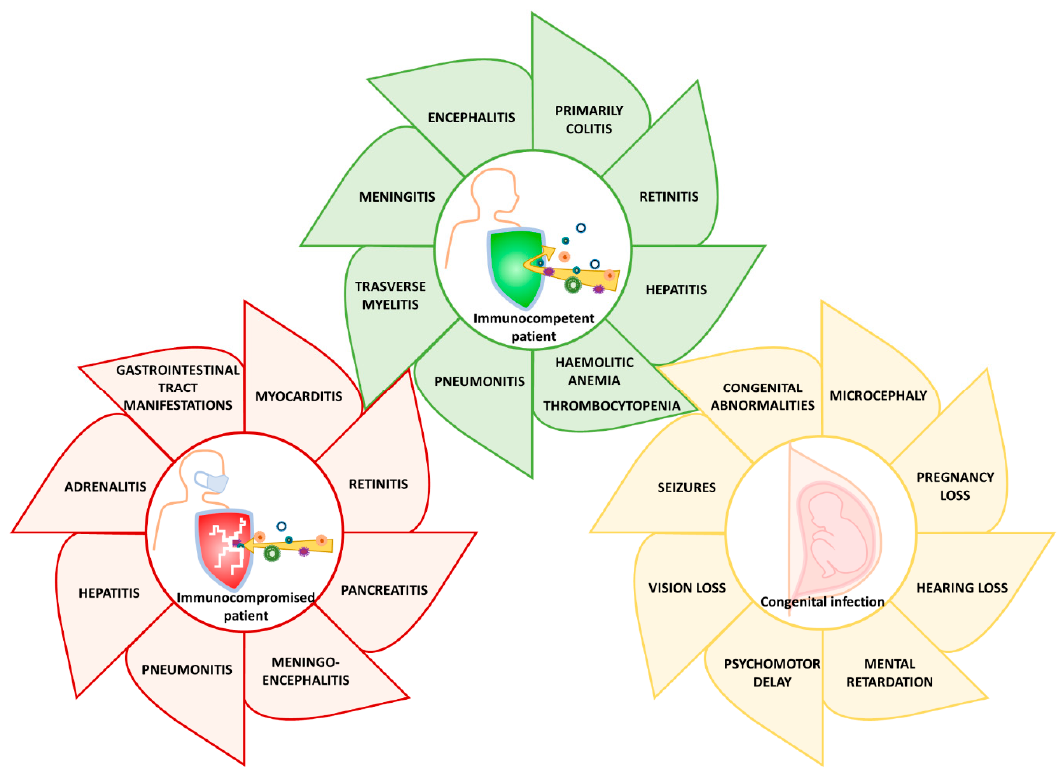
Figure 2. HCMV clinical manifestations in immunocompetent individuals with severe HCMV infection, in immunocompromised people, especially in acquired immune deficiency syndrome (AIDS) patients, transplant recipients, and upon congenital infection.